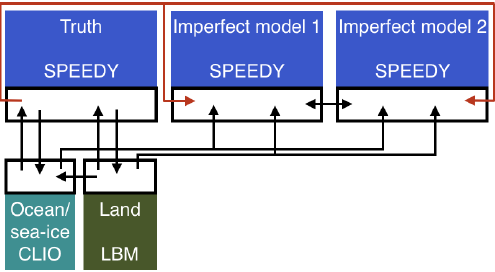
Figure 1. Schematic representation of the SPEEDO climate super- model based on two imperfect atmospheric models. The two atmo- spheric models exchange water, heat and momentum with the per- fect ocean and land model. The ocean and land model send their state information to both atmospheric models. The atmospheric models exchange state information in order to combine their states (Schevenhoven et al., 2019).